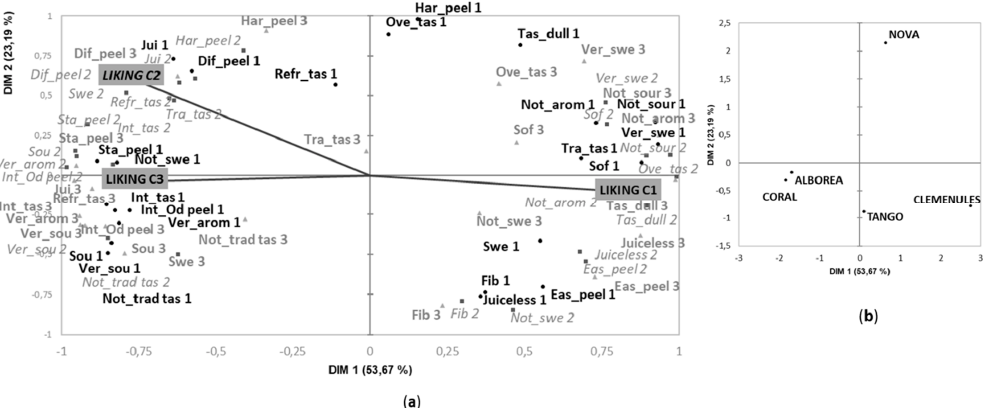
Figure 3. MFA of the CATA question in Harvest 1 considering responses for each of the three identified clusters as active datasets and mean liking scores as supplementary data: ( a ) vocabulary and liking (Cluster 1: black circle; Cluster 2: grey square; Cluster 3: light grey triangle); and ( b ) samples representation. DIM—dimension. Short forms of the CATA terms followed by numbers 1, 2 and 3 (corresponding to each cluster) appear in the MFA and their meanings are the following: Difficult to peel, Dif_peel ; Easy to peel, Eas_peel; Intense odor when starting to peel, Int_Od peel ; Stain hands when peeling, Sta_peel ; Hard starting peeling, Har_peel ; Very aromatic, Ver_arom ; Not very aromatic, Not_arom ; Refreshing taste, Refr_tas ; Not traditional / novel taste, Not_trad tas ; Not very sweet, Not_swe ; Sweet, Swe ; Very swee, Ver_swe ; Tasteless / dull, Tas_dull ; Very intense taste, Int_tas ; Traditional mandarin taste, Tra_tas ; Not very sour, Not_sour ; Sour, Sou ; Very sour, Ver_sou ; Juicy, Jui ; Soft, Sof ; Overripe taste, Ove_tas ; Juiceless,